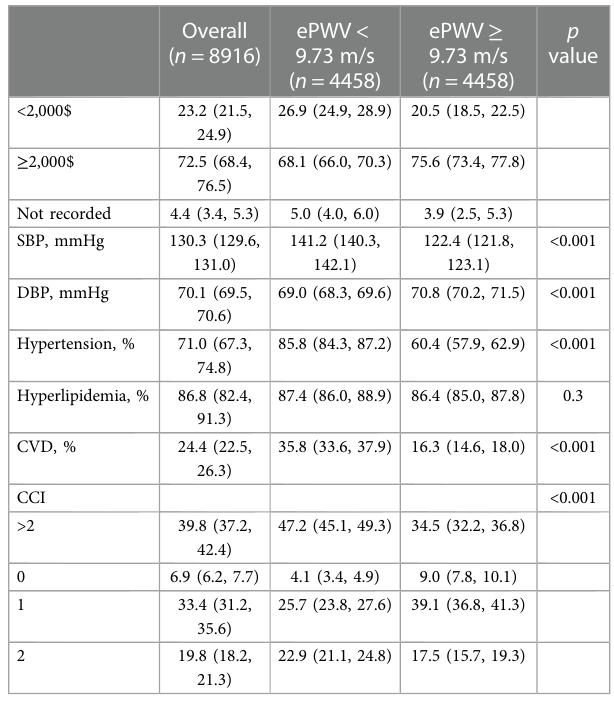
(85.8% vs. 60.4%) and other cardiovascular diseases. The proportion of participants with CCI ≥ 2 was signi fi cant higher in participants with ePWV. The comparison of Table 2 .